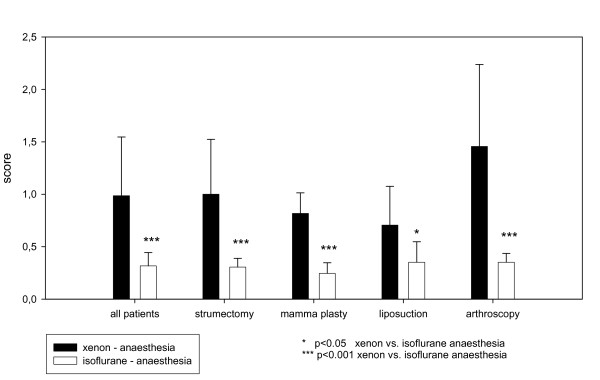
Mean Recovery Index.